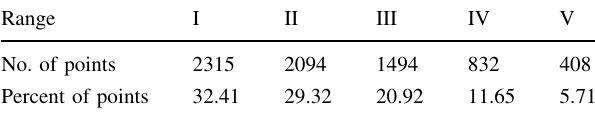
Table 10 Statistics of comparison of the disturbed point cloud with NURBS surface from MS mesh